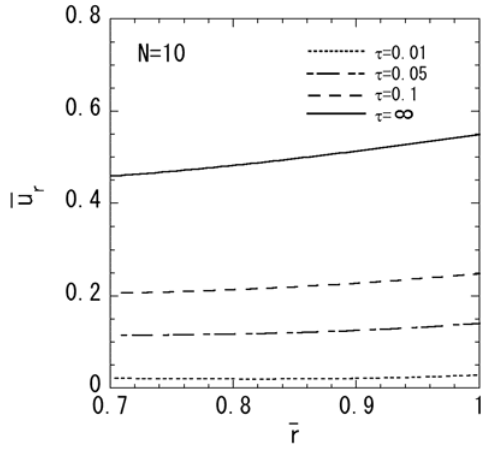
Figure 2. Variation of the